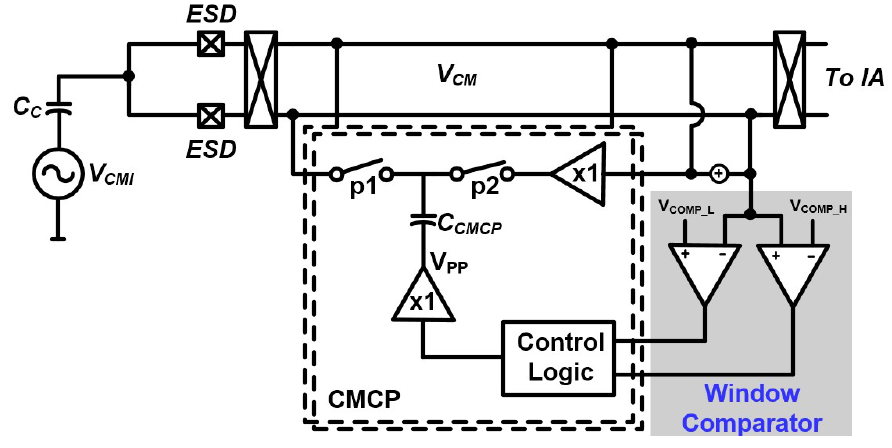
Figure 4. Top architecture of the proposed CMCP.